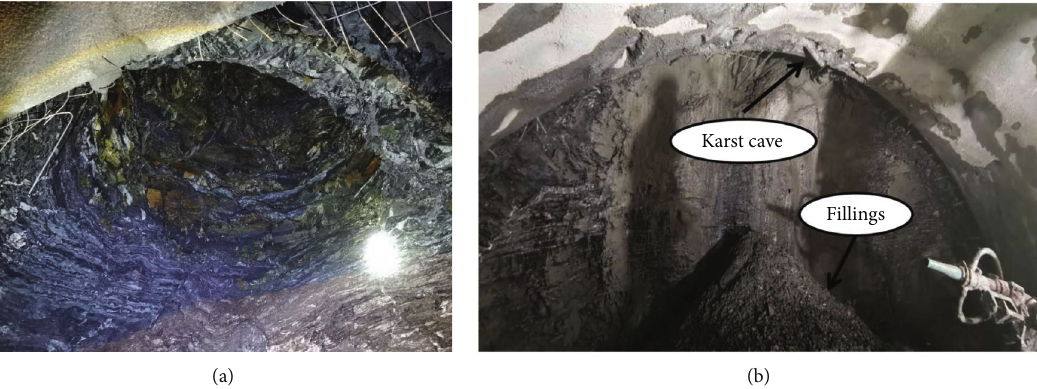
Figure 1: The condition of the palm surface at DK114+070: (a) karst cave and (b) fi llings from the karst cave. Table 1: Methods for predicting watery karst